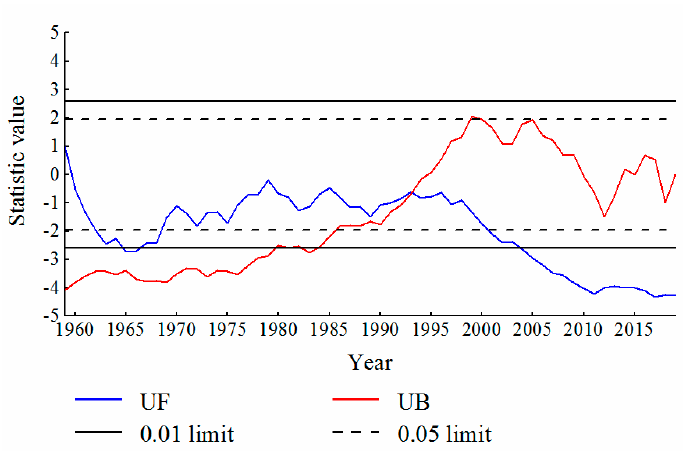
Figure 9. The M-K test result of annual SPEI values.